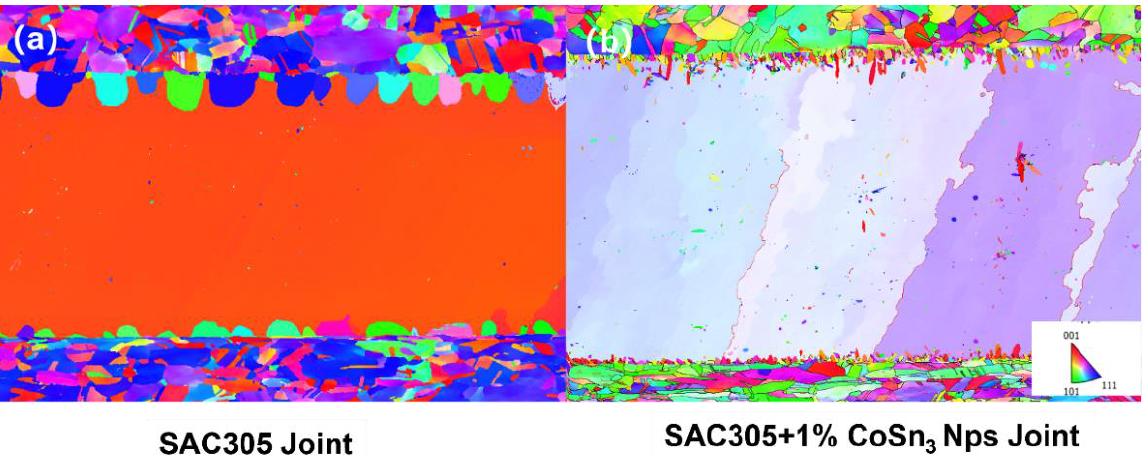
Figure 10. EBSD analysis results. ( a ) SAC305 joint; ( b ) SAC305 + 1 wt.% CoSn 3 nanoparticles.